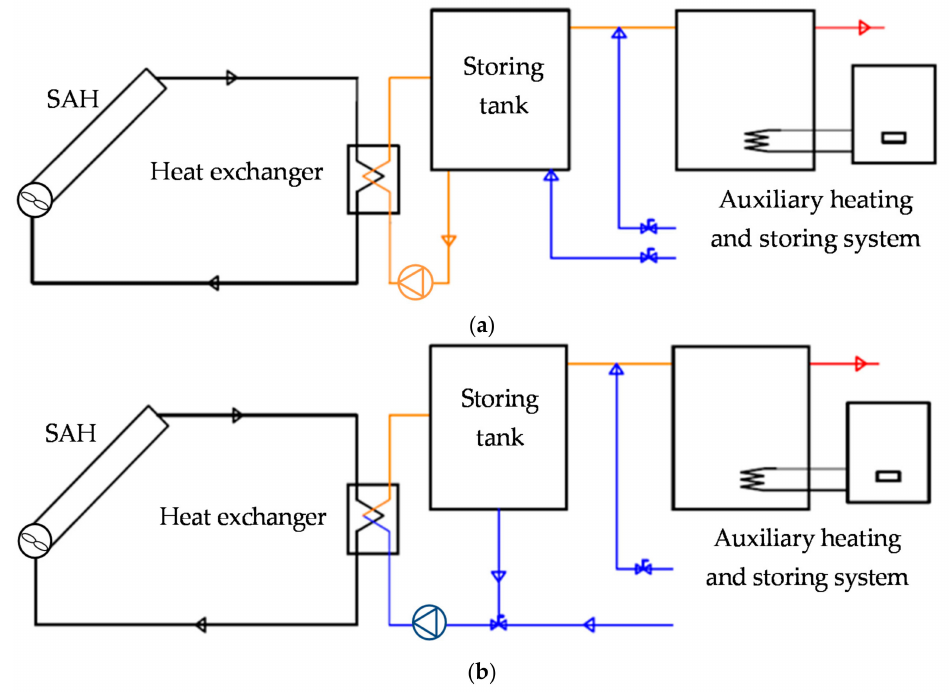
Figure 6. Possible configurations with two tanks: ( a ) water reposition to the tank; and ( b ) water reposition mixed with return water from the